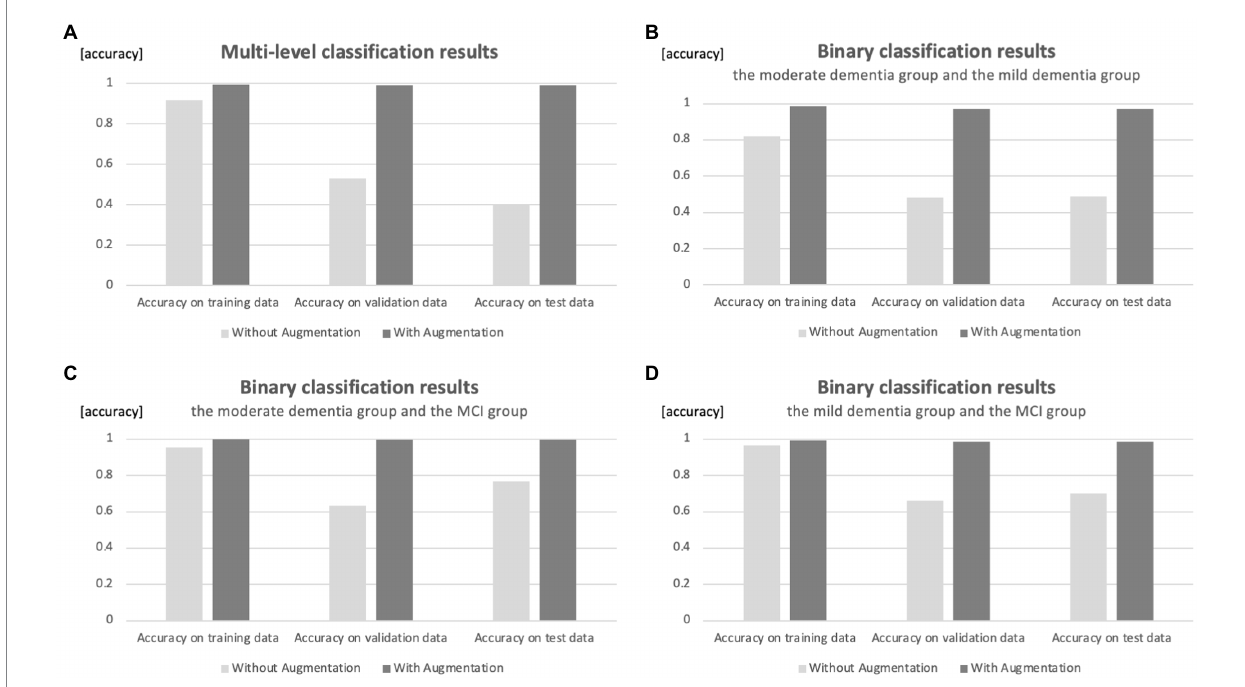
FIGURE 2 Comparison of accuracy results with and without augmentation. (A) Classification of three groups. (B) Binary classification of moderate and mild dementia groups. (C) Binary classification of moderate dementia and MCI groups. (D) Binary classification of mild dementia and MCI